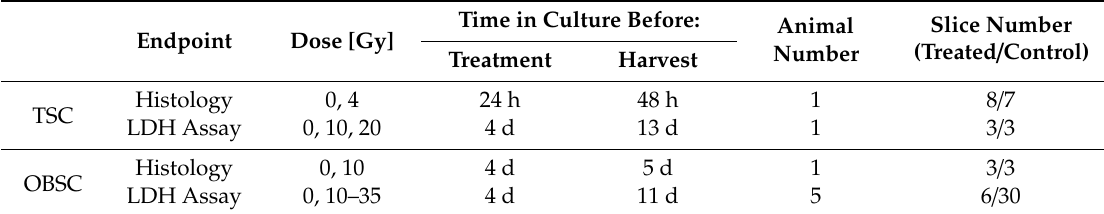
Table 2. Overview of the Individual Treatment Conditions and